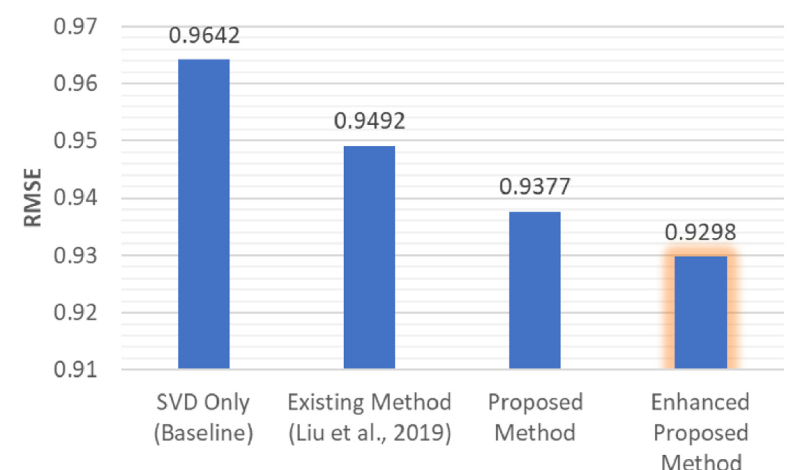
Figure 6. Lowest RMSE value comparison between various methods.